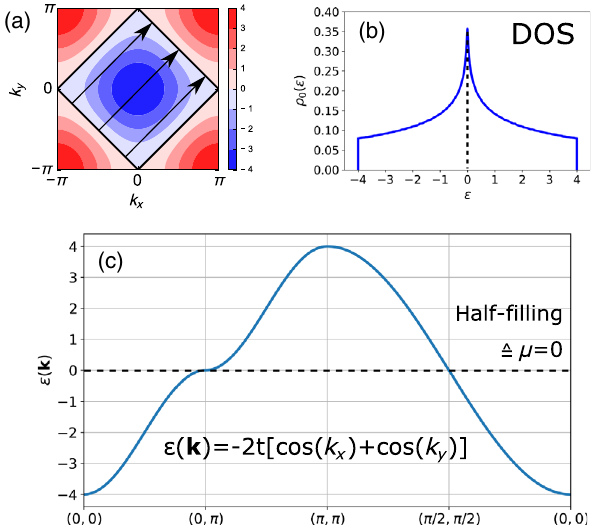
FIG. 1. (a) Momentum distribution of the (noninteracting) dispersion relation of the simple square lattice, Eq. (2), for t ¼ 1 throughout the first Brillouin zone. The Fermi surface of the half-filled system ( μ ¼ 0 ) is diamond shaped (bold black); the black arrows indicate the nesting vectors, mutually connecting Fermi-surface points. (b) Corresponding (particle-hole symmet- ric) density of states (DOS) as a function of energy ρ 0 ð ε Þ . Here, ε ¼ 0 corresponds to half-filling. (c) Value of the dispersion relation along a high-symmetry path exhibiting a plateau around ð π ; 0 Þ , leading to a vanishing Fermi velocity v F